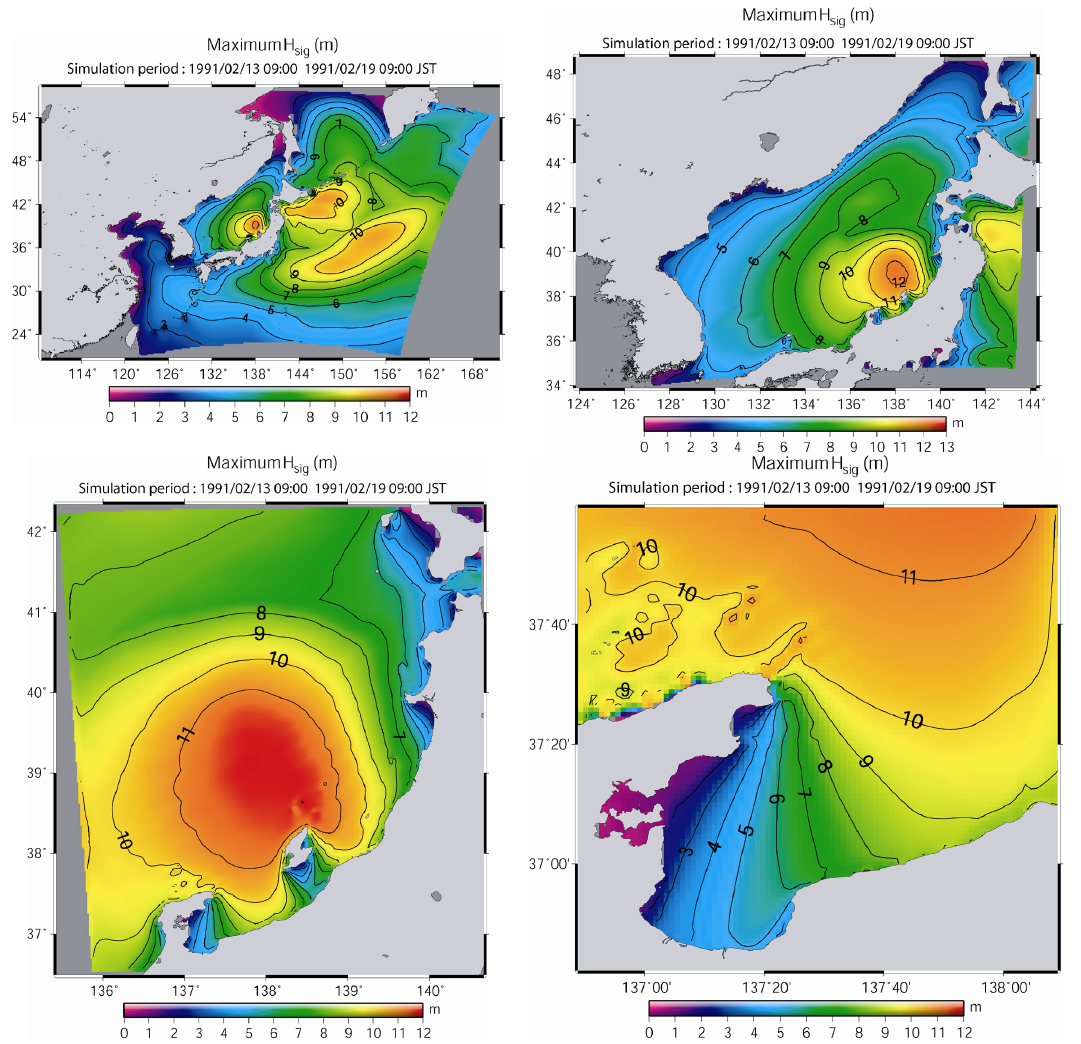
Fig. 9. Distribution of calculated maximum significant wave heights for domain 1, 2, 3, and 4 for the event of February 1991 using JRA-25 for initial and boundary conditions of MM5.